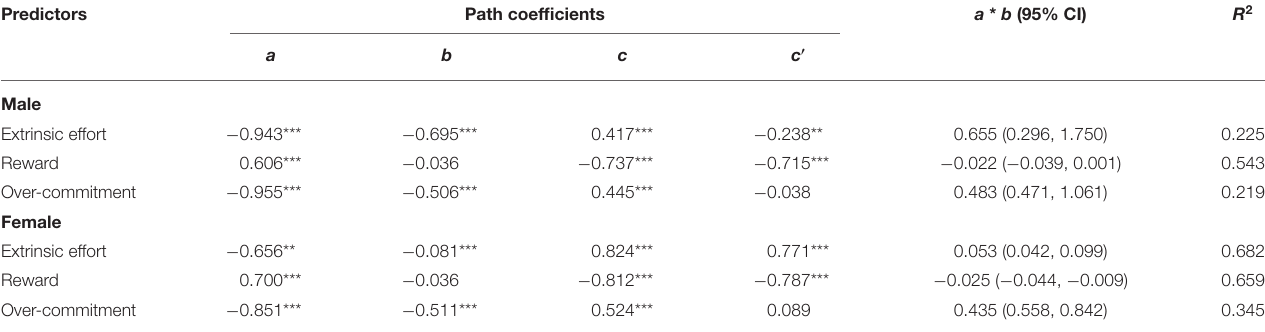
TABLE 4 | Regression analysis, using psychological capital as a mediator and depersonalization as an outcome.